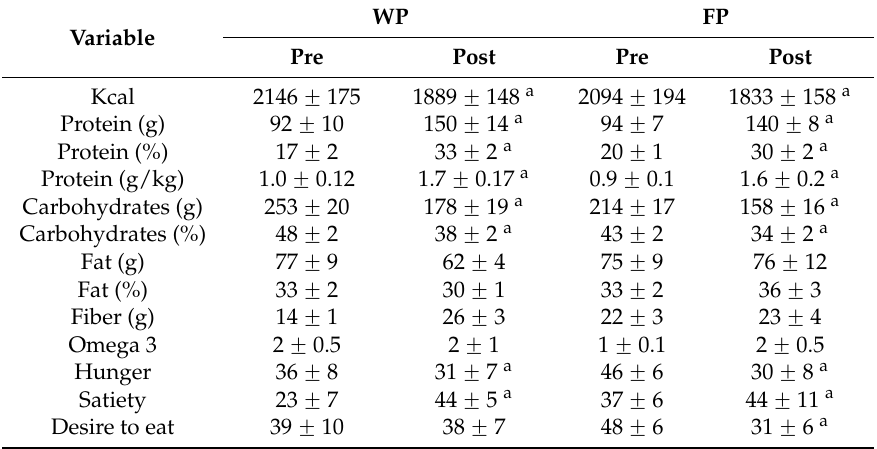
Table 4. Dietary intake and hunger ratings at baseline and